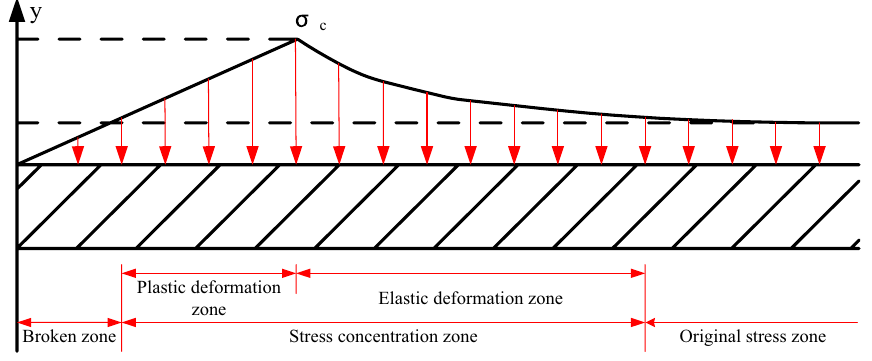
Figure 3. Stress zoning characteristics in the side of a roadway side after coal excavation.